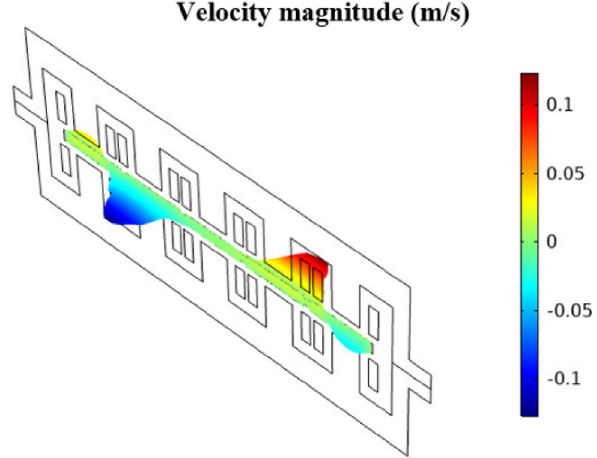
Fig.13 The pressure variations of the active electromagnets num- ber 2 and 4